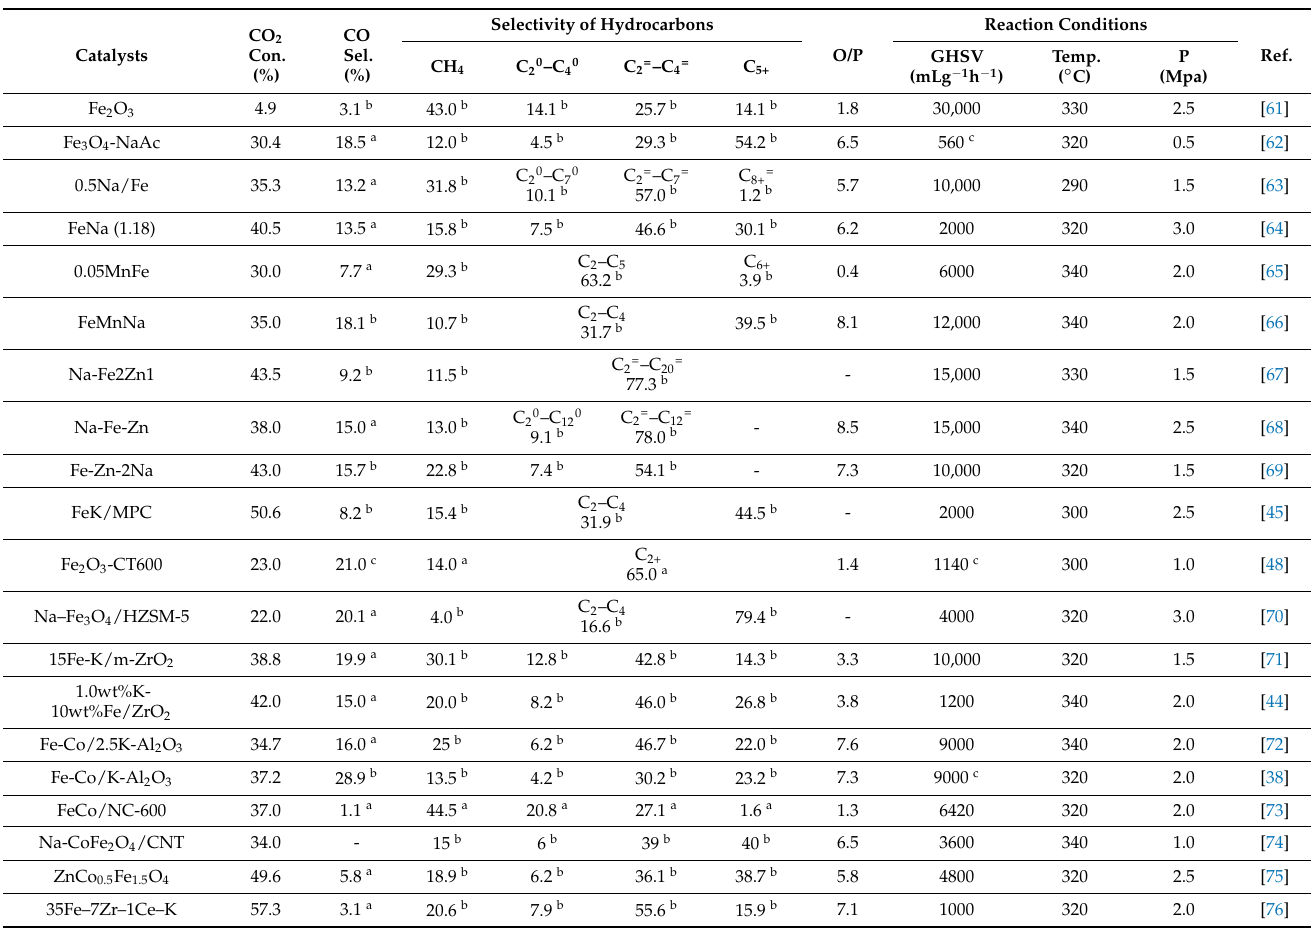
Table 1. Summation of Fe-based catalysts used for CO 2 hydrogenation to